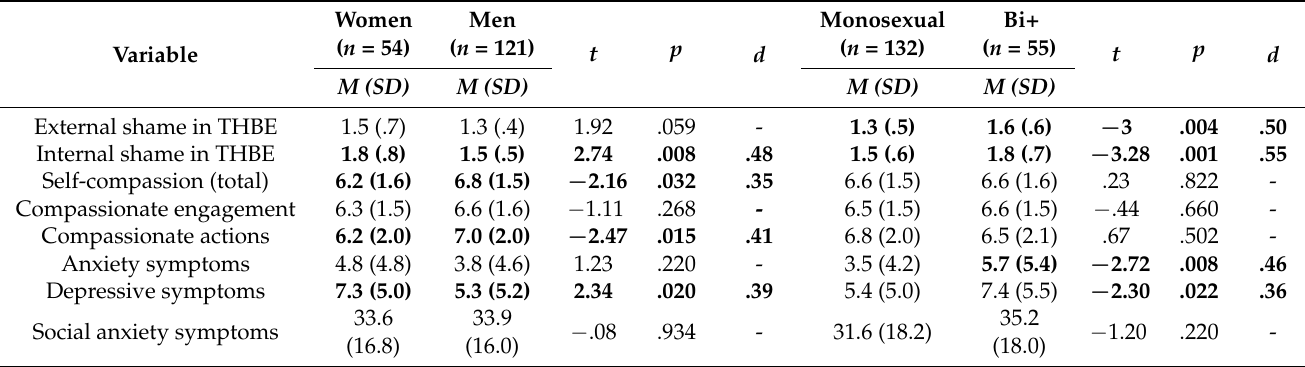
Table A1. Mean comparison considering gender and sexual orientation in study